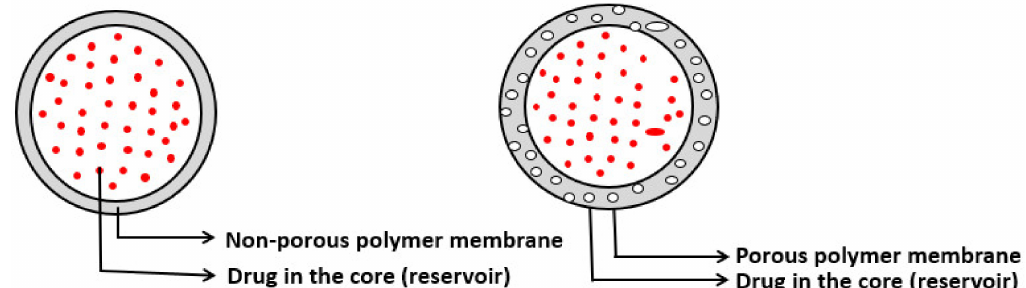
Figure 25. Membrane-controlled drug delivery systems.